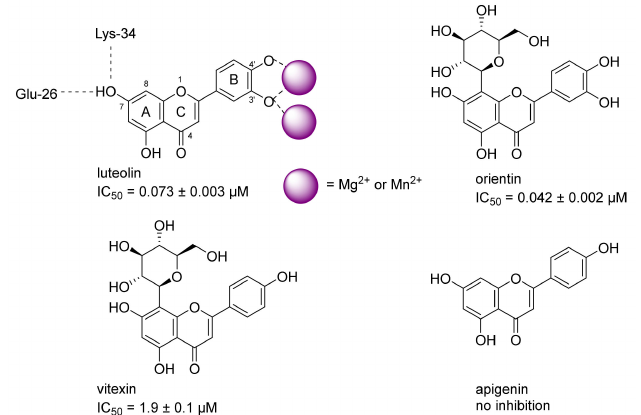
Figure 1. Selected hits from previous screening campaigns are shown. The tight coordination of metal ions and interactions with PA-Nter residues are indicated on the structure of